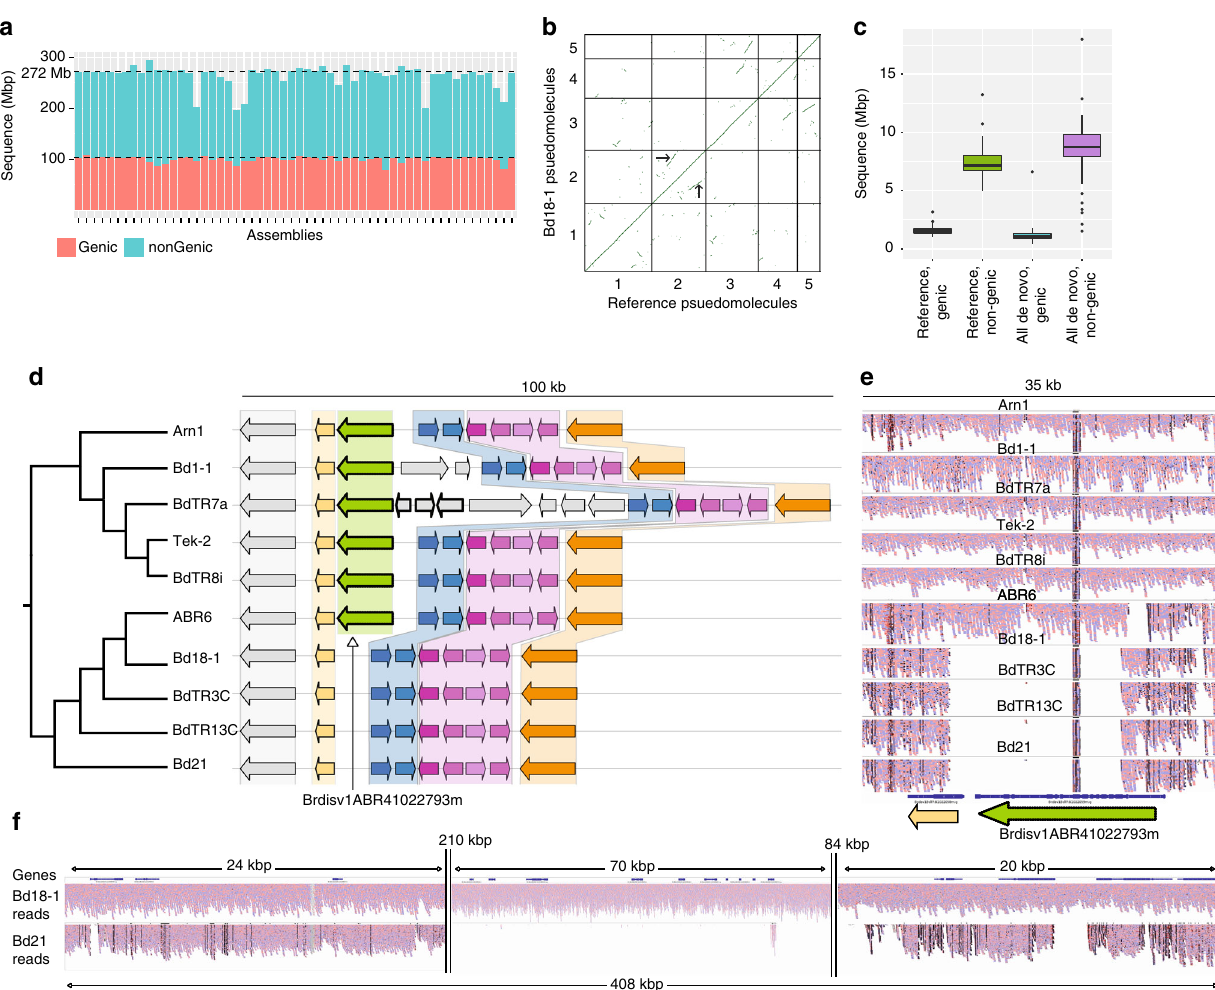
Fig. 1 Genome assembly and analysis. a Genome assembly size and coding sequence for all lines. Dashed lines correspond to the reference genome size and amount of coding (red) and non-coding (blue) sequence. See Supplementary Table 2 for line names and assembly statistics. b Dotplot of syntenic genes between Bd18-1 scaffolds and the reference genome. Note that the short syntenic segments (one example indicated by arrows) off the main diagonal line are signatures of an ancient whole-genome duplication. These short segments are apparent even when comparing the reference genome to itself 22 and are not assembly artifacts. c Similar amounts of coding and non-coding sequence are estimated to be absent in each line, measured by coverage of short reads from respective lines to the reference genome sequence, or alignment of reference short reads to respective de novo assemblies. Whiskers show data within 1.5 times the interquartile range (IQR). d Syntenic representation of the locus contining the non-reference pan-gene BrdisvABR41022793m . Note that the pan-gene is present in the top six genomes but absent from the bottom four, including the reference genome (Bd21). e Short reads from the lines in d mapped to the BdTR8i genome. Note that read mapping supports the presence/absence of BrdisvABR41022793m . f Short reads from Bd21 and Bd18-1 mapped to the Bd18-1 genome in a region where Bd18-1 contains 408 kb of sequence that is extremely diverged or absent from the reference genome (between the relatively conserved left and right fl anking regions). Note that the interval contains multiple annotated